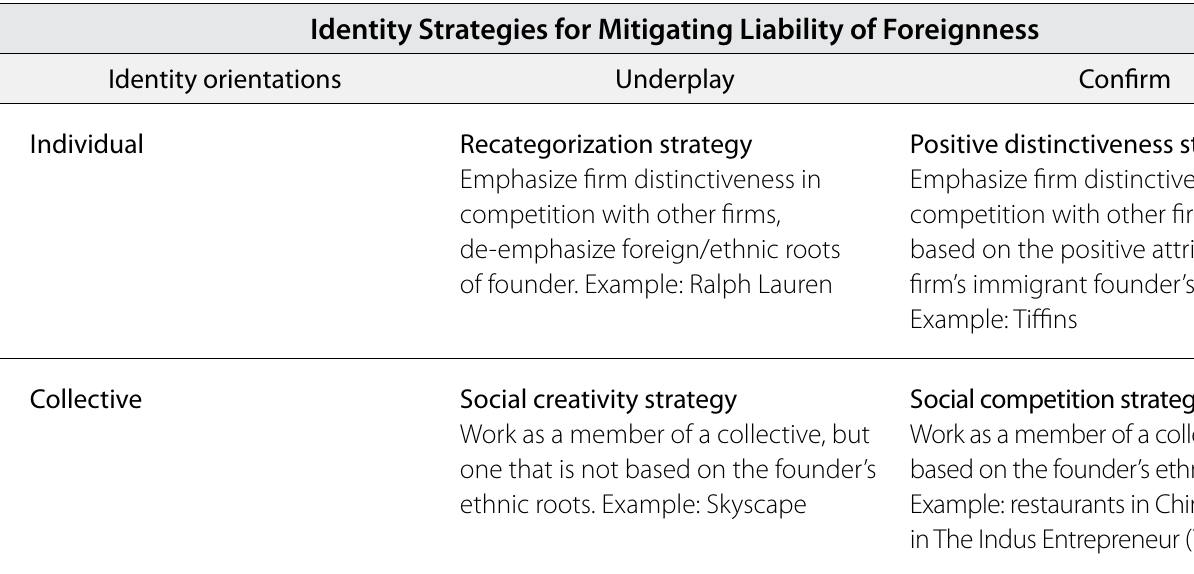
Figure 1. Identity Strategies of Immigrant